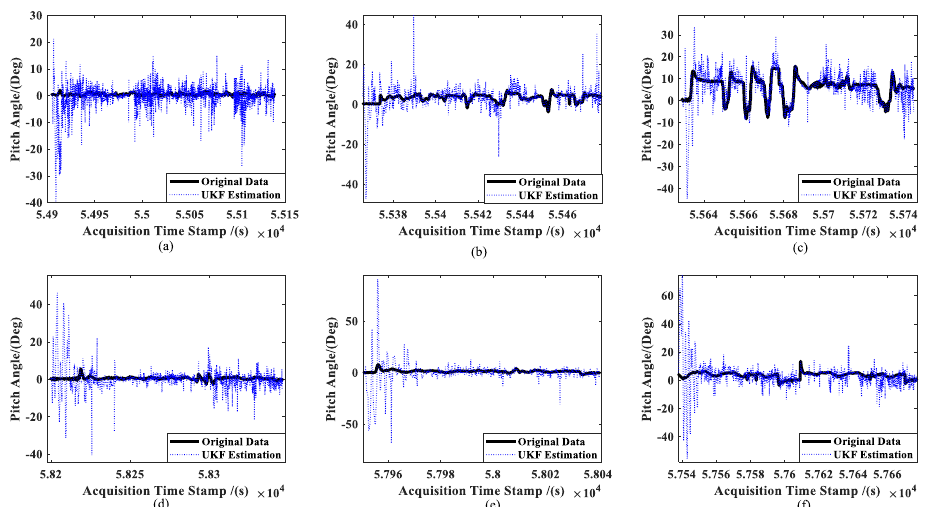
Figure 8. UKF estimation results for the ship’s attitude: ( a ) slow speed of MRM, ( b ) medium speed of MRM, ( c ) high speed of MRM, ( d ) slow speed of ANM, ( e ) medium speed of ANM, and ( f ) high speed of ANM.